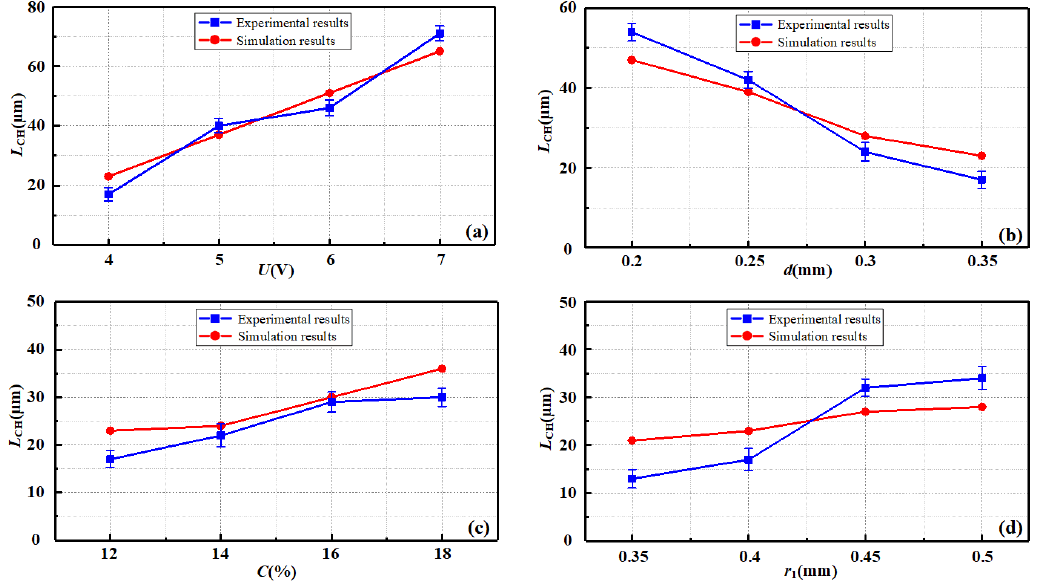
Figure 23. L CH comparison curve: ( a ) Effect of machining voltage; ( b ) Effect of initial machining gap; ( c ) Effect of electrolyte concentration; ( d ) Effect of electrode radius.